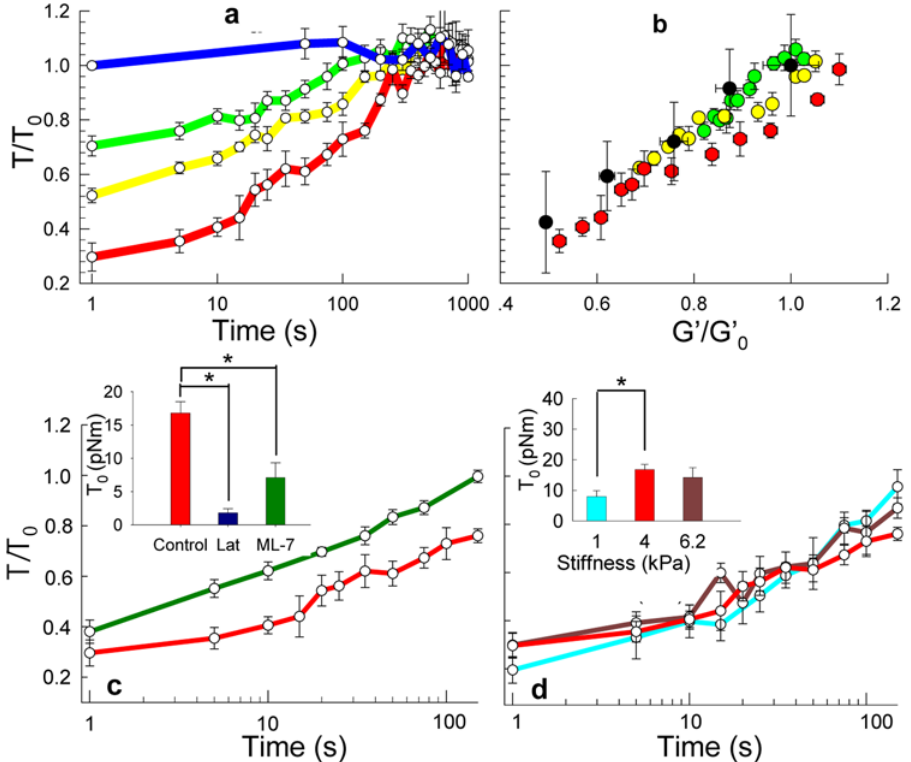
Figure 3. Traction dynamics following a homogeneous biaxial isotropic stretch. a, Tractions as represented by the contractile moment T relative to the unstretched baseline value T 0 versus time, after stretch cessation. The greater was the applied stretch, the greater were the reductions in cell traction, and the faster were the recoveries. Peak strains of: 0 (blue; n=9), 2.5 (green; n=12), 5.0 (yellow; n=11) and 10.0% (red; n=14). b, When traction data from (a) are plotted not versus time, but rather versus the instantaneous value of the cell stiffness (G 9 ), all data collapse.[15] Following a transient cell stretch, cell stiffness (x axis) and cell tractions (y axis) evolved in concert. Similar strong associations between stiffness and tractions have been measured previously[15] in response to graded concentrations of relaxing or contracting agonists, but exclusively under static steady-state conditions (black). c, Dynamic traction measurements in HASM cells treated with ML-7 (dark green; n=13) or Latrunculin (dark blue; n=13). Pharmacologically treated cells were found to exert significantly smaller tractions at baseline compared to untreated cells, often to levels below the measurable range. Observable traction responses to a 10% transient stretch relative to its unstretched baseline value T 0 following stress cessation in ML-7 treated cells (n=5) were similar in quality but markedly different in magnitude. d, Dynamic traction measurements in cells plated on soft (cyan; n=7), intermediate (red; n=14) and stiff (brown; n=10) substrates (Young’s moduli of 1,4, or 6.2 kPa). Despite differences in baseline pre-stretch tractions (inset, * p , 0.05), in response to a 10% transient stretch, normalized traction changes were strikingly similar within the three stiffness groups.